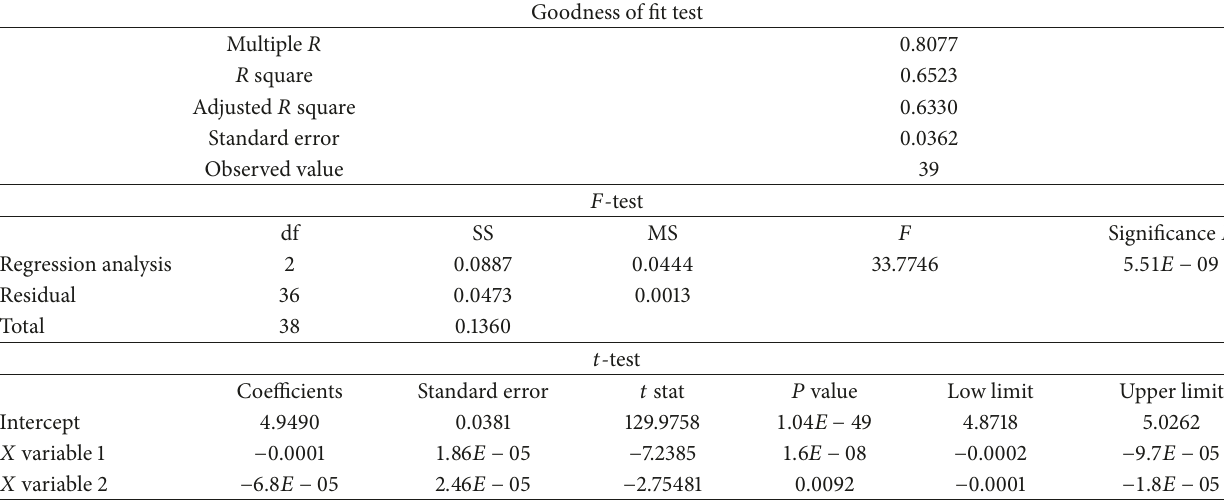
Table 3: Statistical test of speed prediction